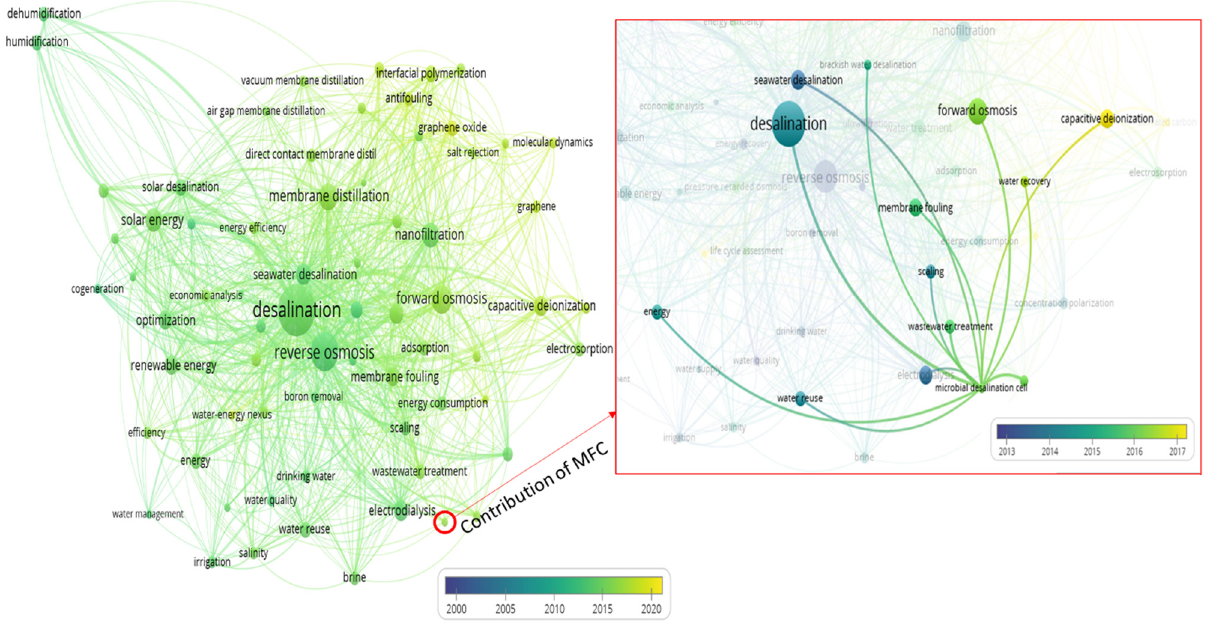
Figure 7: Frequently used keywords in desalination research between 2000 and 2020.